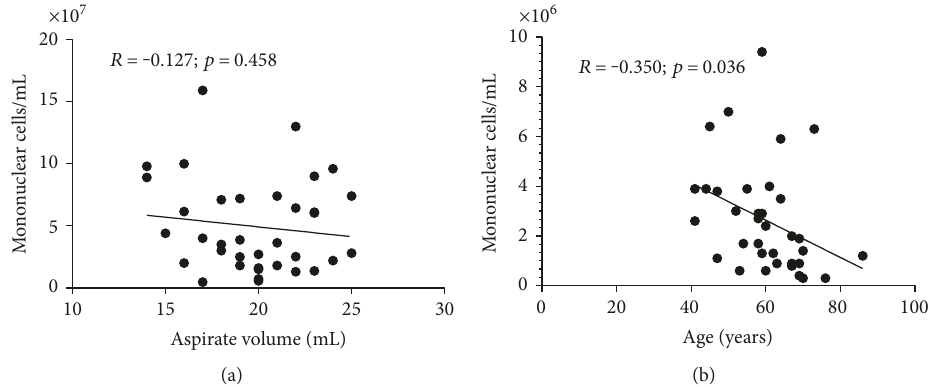
Figure 1: Relationship between the concentration of mononuclear cells and mean volume of the sternal bone marrow collected (a) and age of patients (Table 2). Results were similar for patients with or without LV dysfunction.